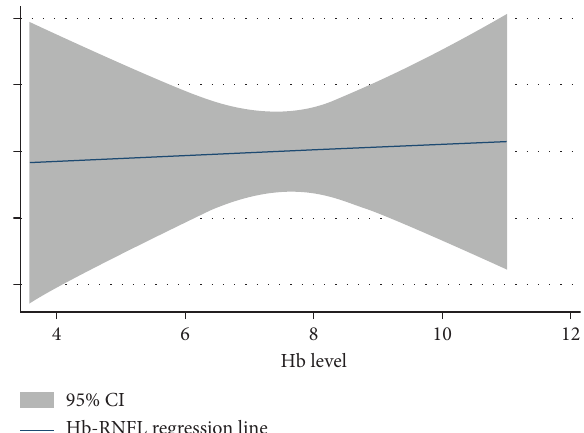
Figure 5: Correlation between the Hb level and RNFL thickness. Fit plot for the RNFL vs. Hb regression